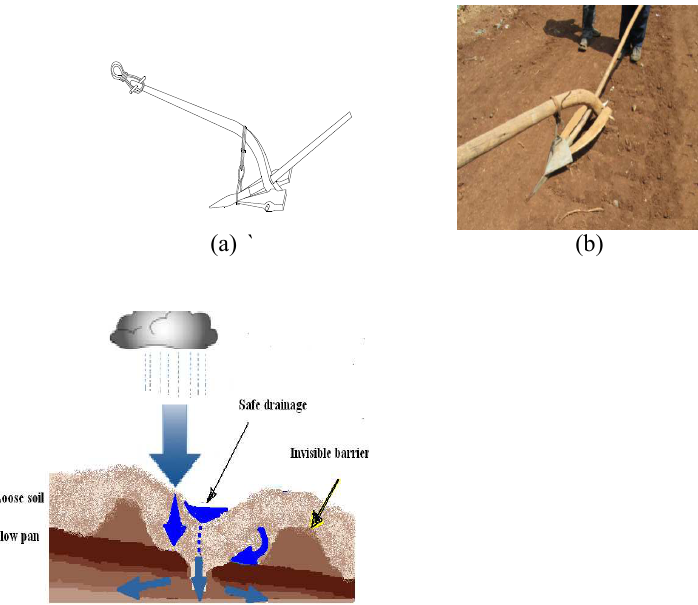
Figure 1. Study sites at Enerata. Predominantly cultivated area in the mid altitudes of the Choke Mountains, headwaters of the Blue Nile river basin. Source of Satellite picture is Google Earth, 2009.